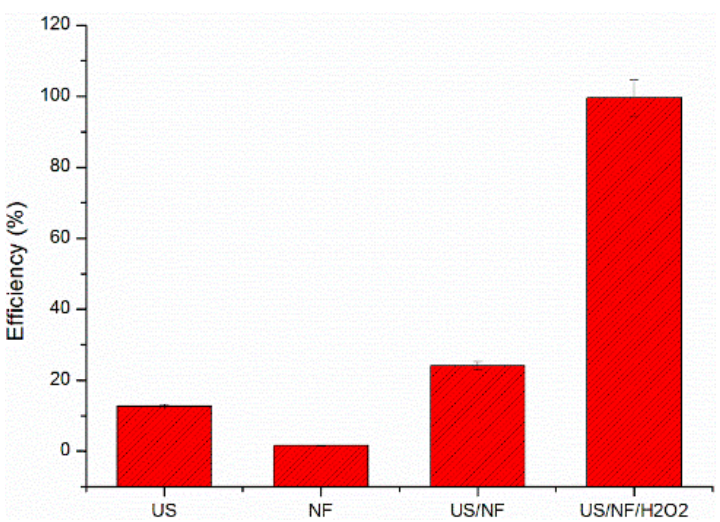
Figure 1. Removal efficiency of rhodamine B (RhB) in different oxidation processes. US, ultrasound; NF, nickel foam.